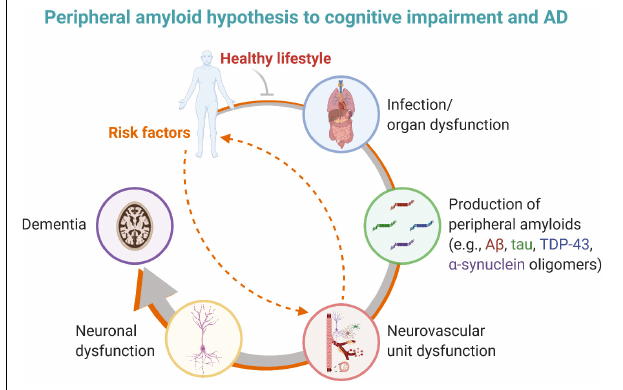
FIGURE 3 | The peripheral amyloid hypothesis to cognitive impairment and AD states that amyloids (e.g., A β , tau, and perhaps TDP-43) are produced in the periphery as an innate immune response to infection or organ dysfunction, inducing neurovascular dysfunction, neurodegeneration, cognitive impairment, and ultimately AD. An individual may have risk factors that provoke and promote infection and/or organ dysfunction or that directly impact neurovascular unit function. A healthy lifestyle may help mitigate this pathological cascade. Created with